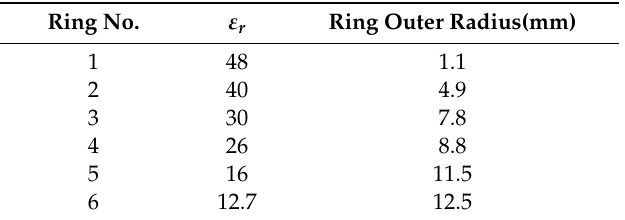
Table 4. Dielectric constant values of the concentric dielectric rings. Ring No.